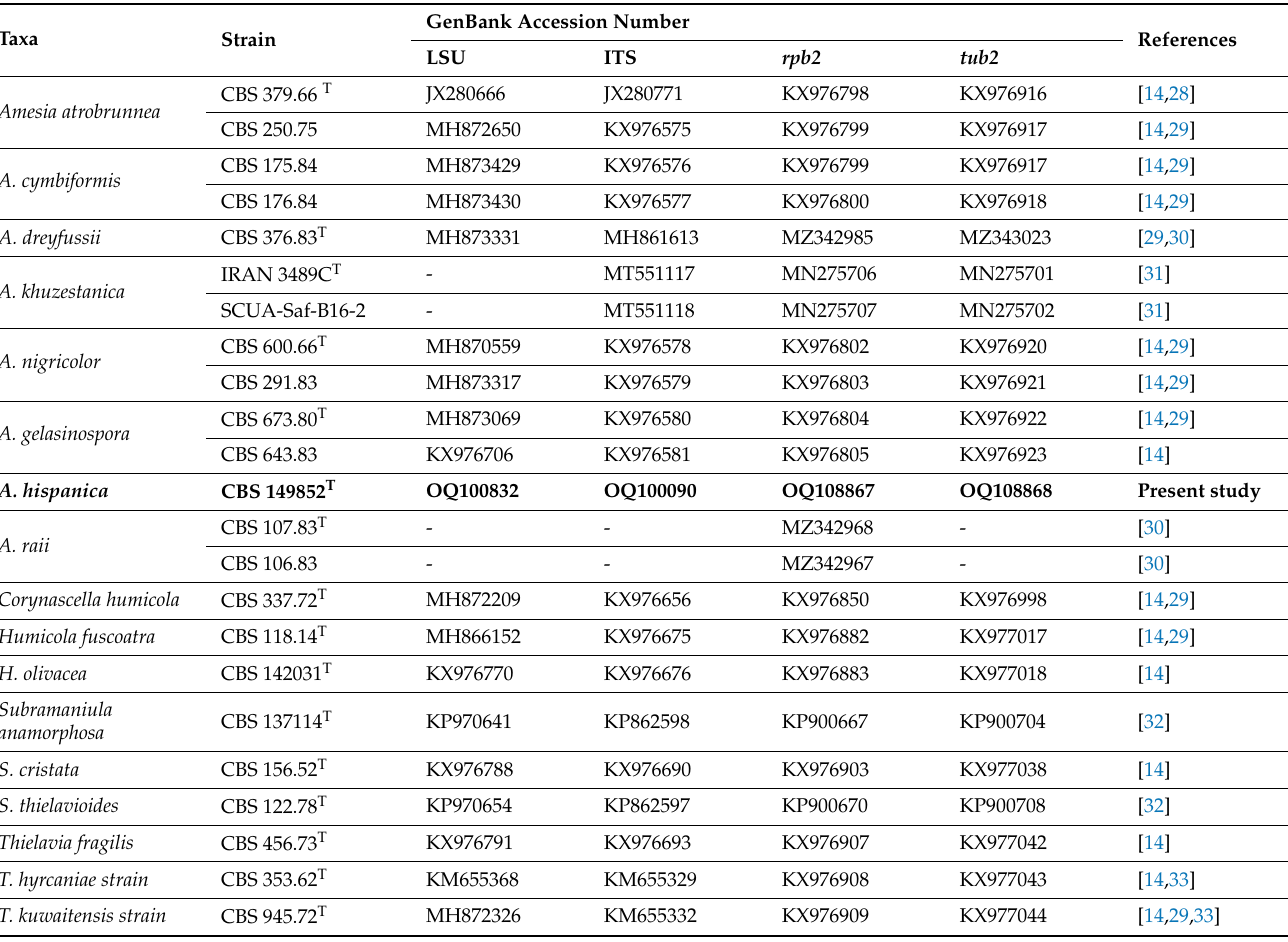
Table 1. Isolates and reference strains of the order Sordariales included in the phylogenetic study. Novel taxon and sequences generated in this study are indicated in